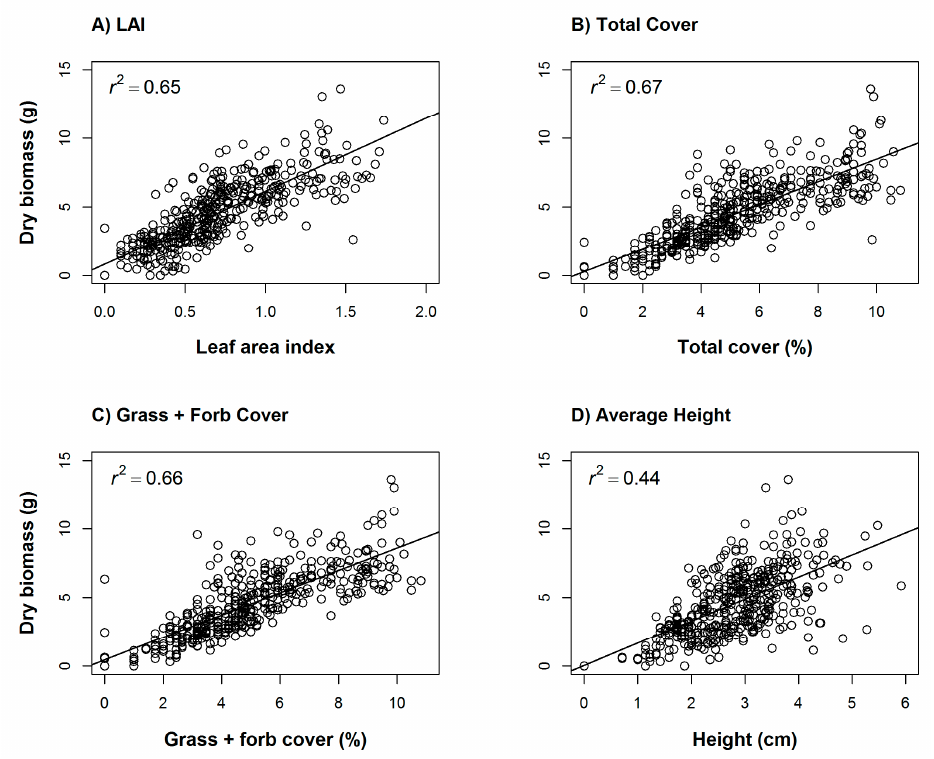
Figure 5. Individual square root transformed variables ( A ) leaf area index (LAI), ( B ) total vegetation cover, ( C ) grass and forb cover, and ( D ) average vegetation height selected for predicting oven dried herbaceous biomass (fine-fuel) that was clipped from quadrats in